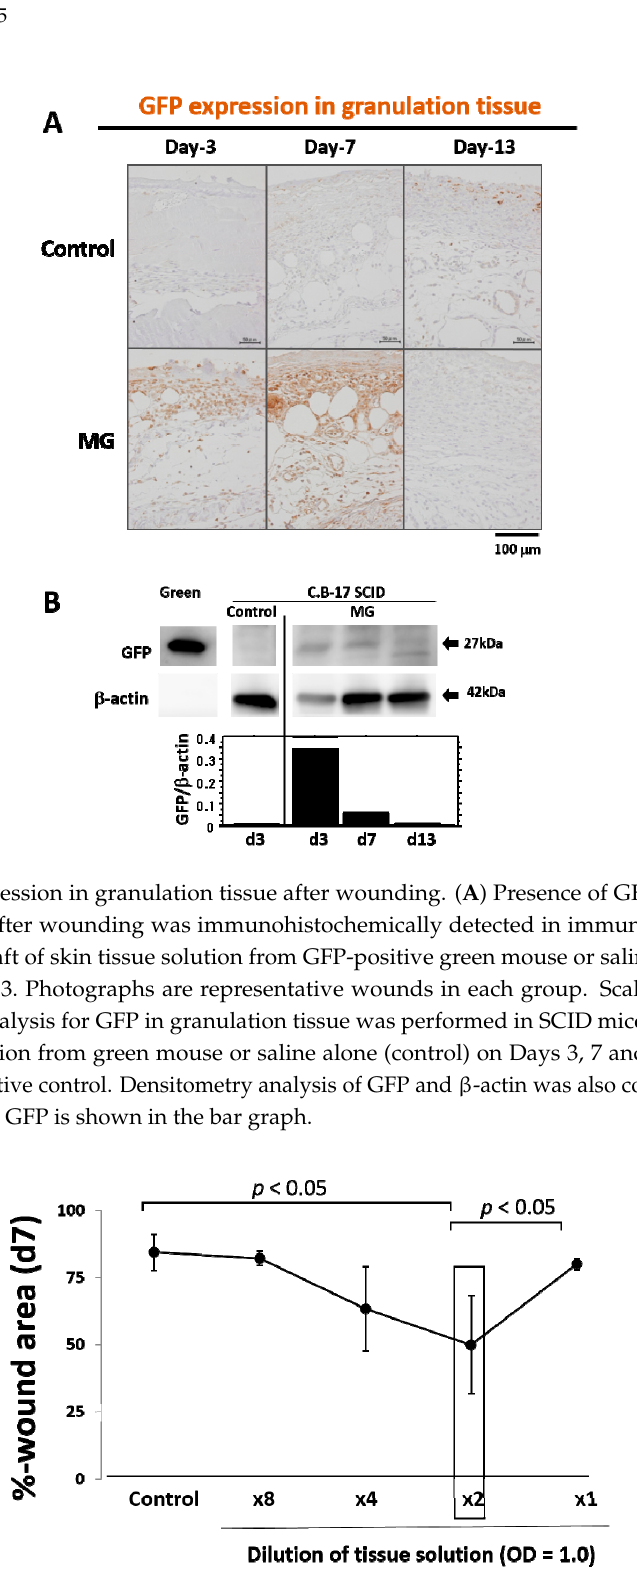
Figure 3. Optimal concentration of micrograft for wound healing. Optimal tissue concentration for wound healing was determined. Normal skin tissue was minced by Rigeneracons ® , and its optical density at wavelengths of 450 nm/550 nm was adjusted to 1.0. The solution was serially diluted (2-, 4- and 8-times), and 200 µ L of each solution were micrografted on the wound. Wound area was measured on seven days of the study, resulting in two-times dilution as optimal. Values: mean ± standard error (SE).